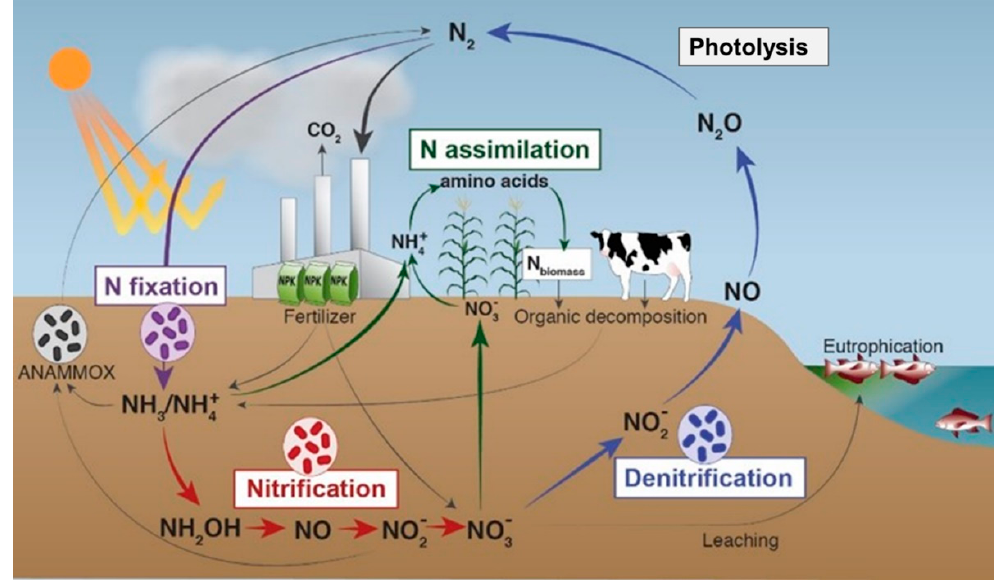
Figure 1. Sinks and sources of N 2 O in the N-cycle (source: Lehnert et al. [28].